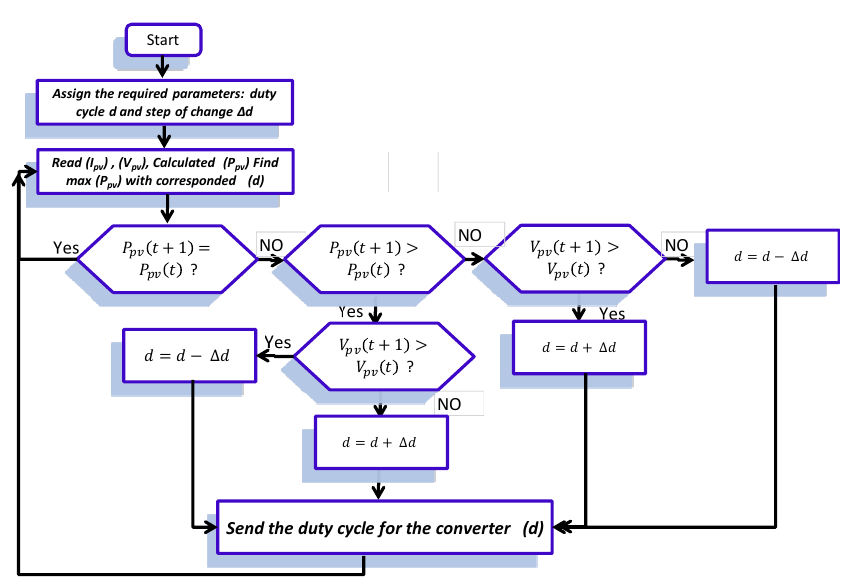
Figure 8. Flowchart of P&O technique.